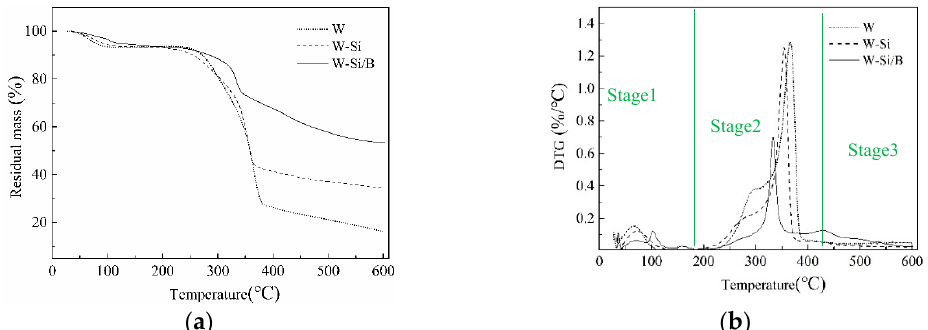
Figure 6. The change in ( a ) residual mass and ( b ) derivative thermogravimetric.